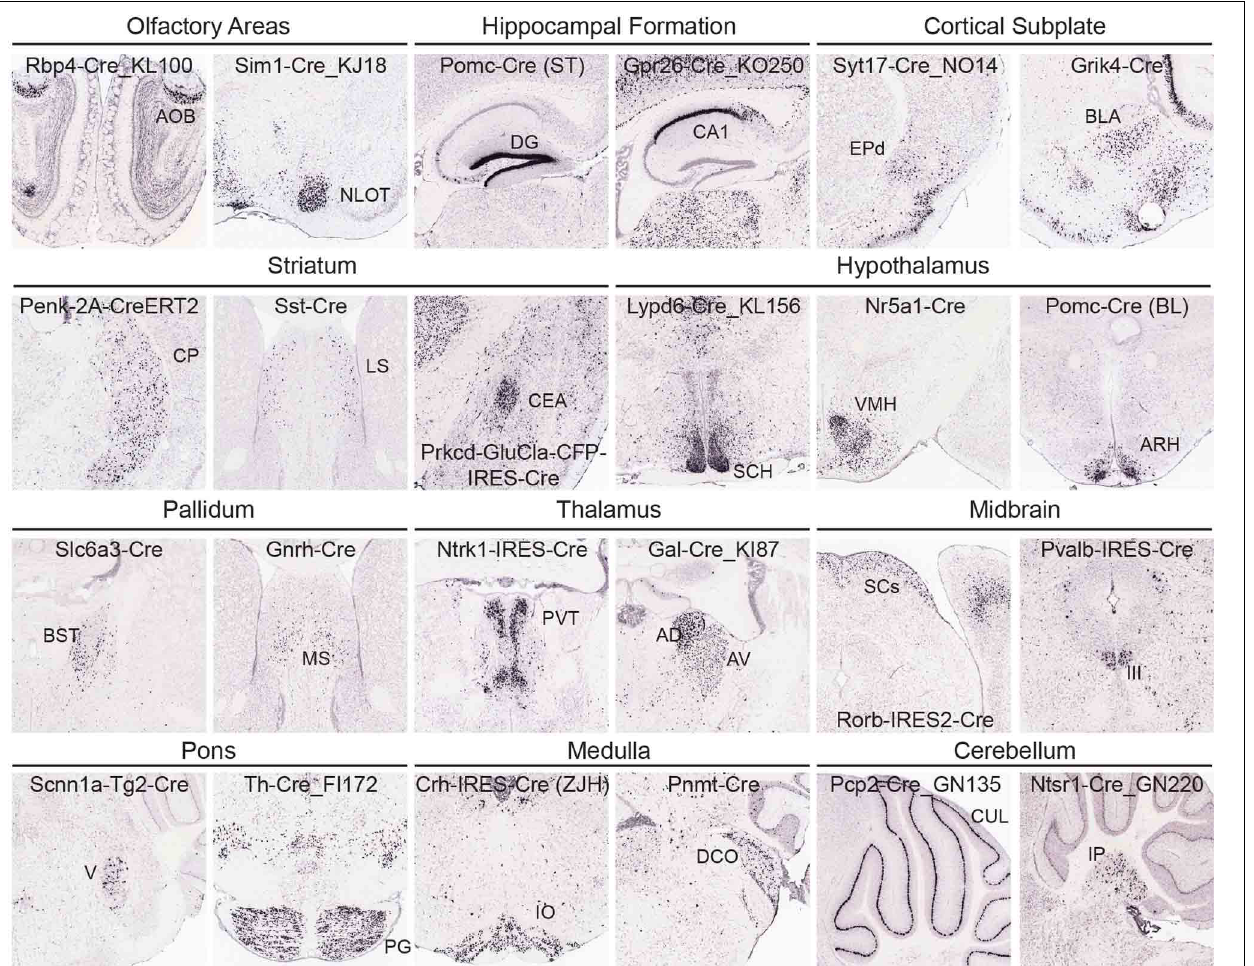
FIGURE 5 | Cre lines provide genetic access to specific brain areas through enriched or restricted gene expression patterns. Within this collection of 135 characterized Cre lines, enriched expression patterns can be seen in nuclei from all major brain regions. Representative examples of Cre lines with region-selective expression patterns of the tdTomato reporter are shown within olfactory areas (Rbp4-Cre_KL100, Sim1-Cre_KJ18), hippocampal formation (Pomc-Cre (ST), Gpr26-Cre_KO250), cortical subplate (Syt17-Cre_NO14, Grik4-Cre), striatum (Penk-2A-CreERT2, Sst-Cre, Prkcd-GluCla-CFP-IRES-Cre), hypothalamus [Lypd6-Cre_KL156, Nr5a1-Cre, Pomc-Cre (BL)], pallidum (Slc6a3-Cre, Gnrh-Cre), thalamus (Ntrk1-IRES-Cre, Gal-Cre_KI87), midbrain (Rorb-IRES2-Cre, Pvalb-IRES-Cre), pons (Scnn1a-Tg2-Cre, Th-Cre_FI172), medulla (Crh-IRES-Cre(ZJH),